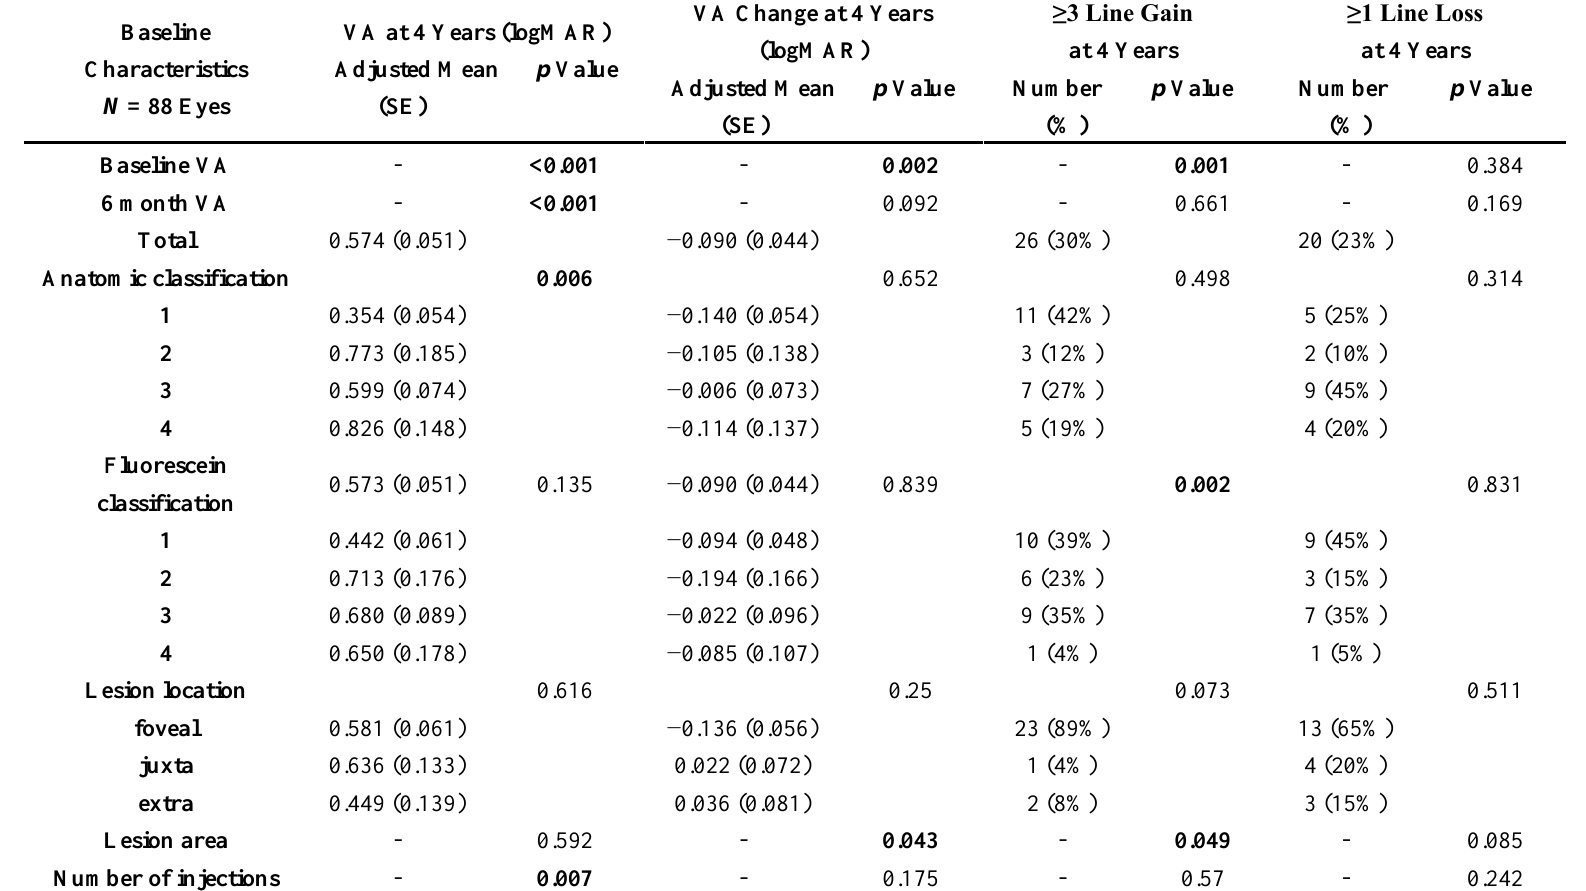
Table 3. Bivariate associations of baseline clinical variables and visual parameters at 4